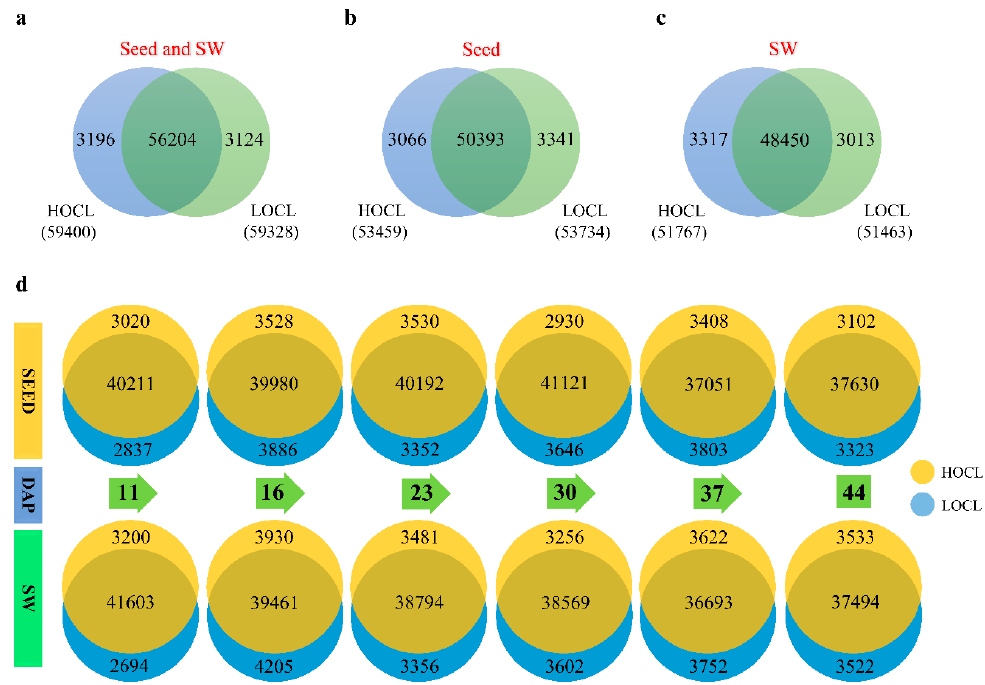
Figure 2. Genes expressed (fragments per kilogram of transcript per million mapped reads (FPKM) ≥ 1) in seed and silique wall of the HOCL and LOCL. ( a ) Seed and SW; There were 59,400 and 59,328 genes expressed in seed and silique wall of the HOCL and LOCL, respectively, with 56,204 genes co-expressed in both lines and 3196 and 3124 specifically expressed in each line. ( b ) Seed; There were 50,393 co-expressed genes, 3066 (HOCL) and 3341 (LOCL) genotype-specific expressed genes, and 53,459 and 53,734 total genes expressed in the HOCL and LOCL, respectively ( c ) Silique wall; There were 48,450 co-expressed genes, 3317 (HOCL) and 3013 (LOCL) genotype-specific genes, and 51,767 and 51,463 total genes expressed in the HOCL and LOCL, respectively. ( d ) Dynamics of genes expressed in seed and SW tissues of the HOCL and LOCL along with the development, and changing expression patterns of genes along with the development of seed and SW of the HOCL and LOCL.